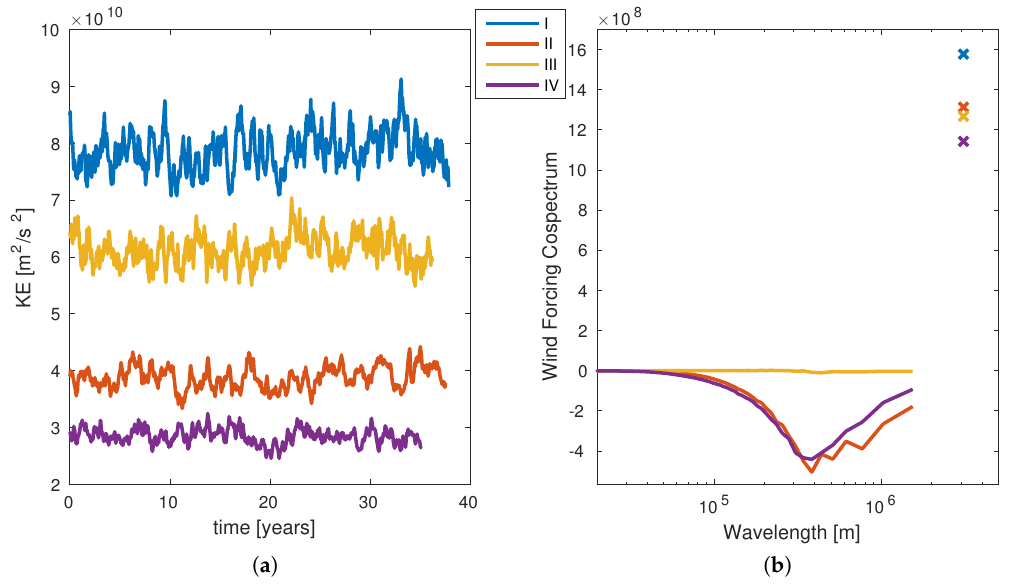
Figure 2. ( a ) Time series of total horizontal "kinetic energy" | u | 2 /2; and ( b ) cospectra of wind power input; the plot is normalized such that total power (watts) is obtained by summing up the cospectrum. The wind power input at the largest scale is denoted by × symbols, and has been divided by a factor of 10 to fit on the same axes. Symbols I – IV indicate the wind stress formulation used in the